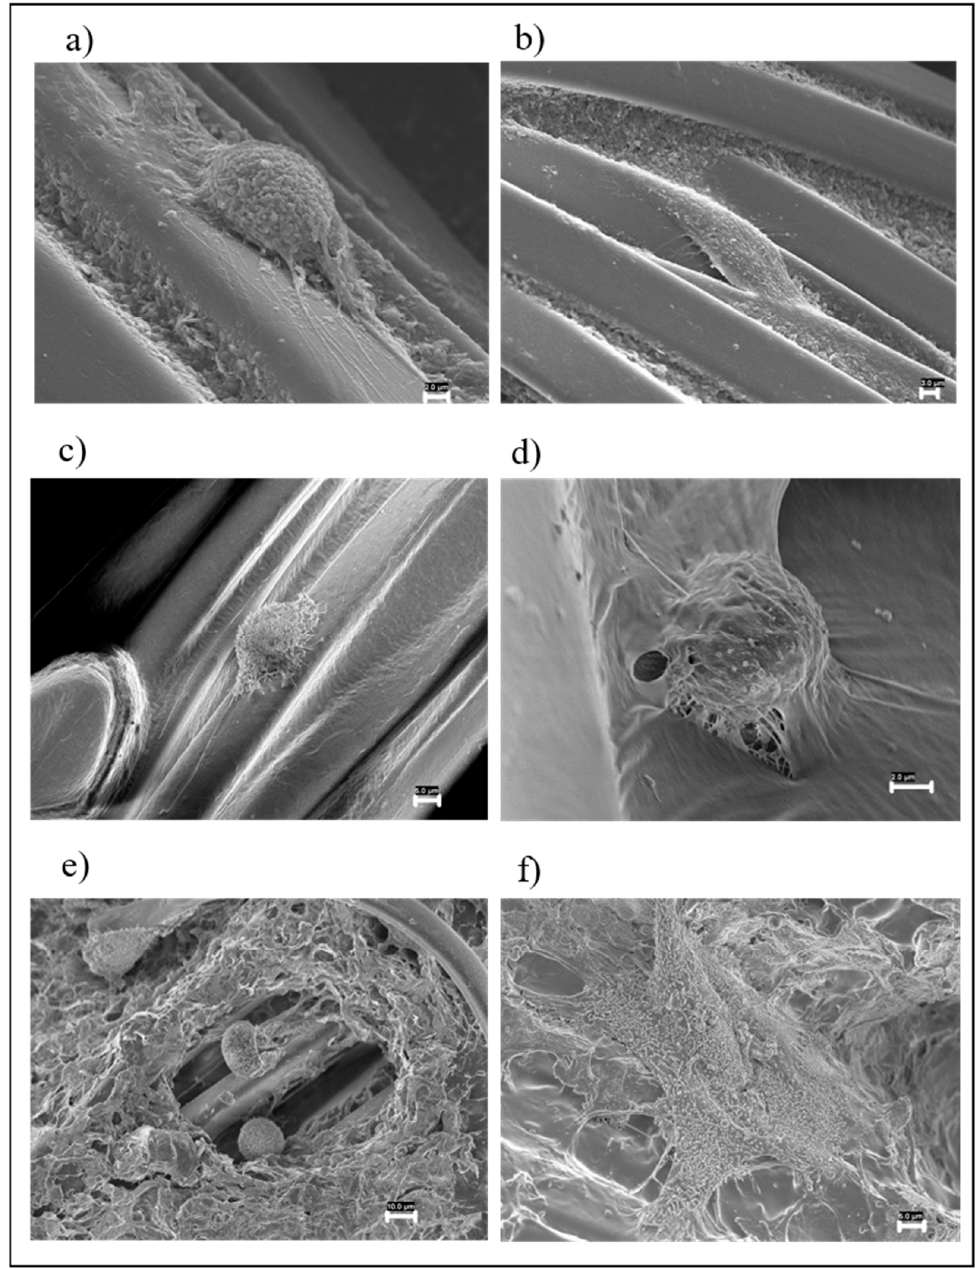
Figure 6. HaCaT cells grown on fabrics: ( a ) (Bar 2 μ m) and ( b ) (Bar 3 μ m) UT; ( c ) P1 (Bar 5 μ m); ( d ) P2 (Bar 2 μ m); ( e ) P1GNPs (Bar 10 μ m); ( f ) P2GNPs (Bar 5 μ m).